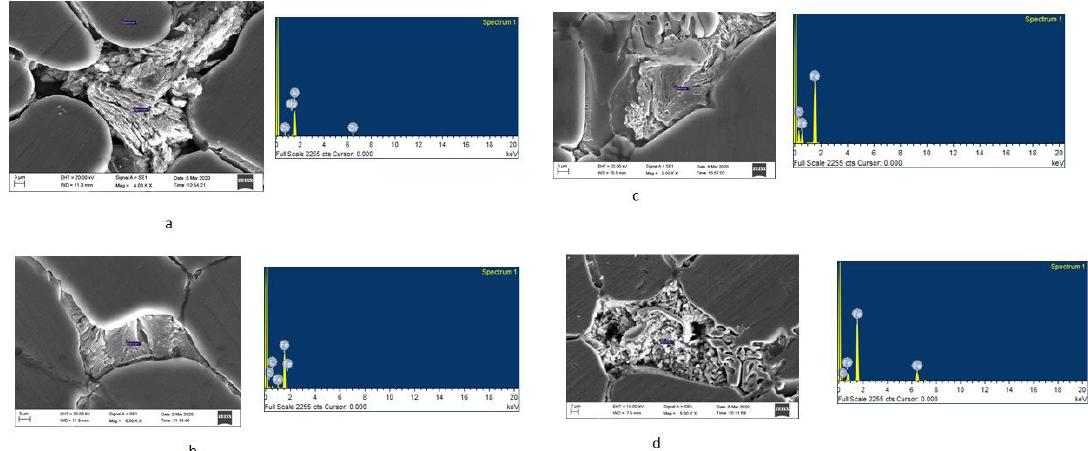
Figure 14. SEM micrographs with EDAX of a) conventionally b) hybrid pearlite formed c) hybrid bainite formed d) hybrid martensite formed peak aged Al 7075-6 wt% steel powder